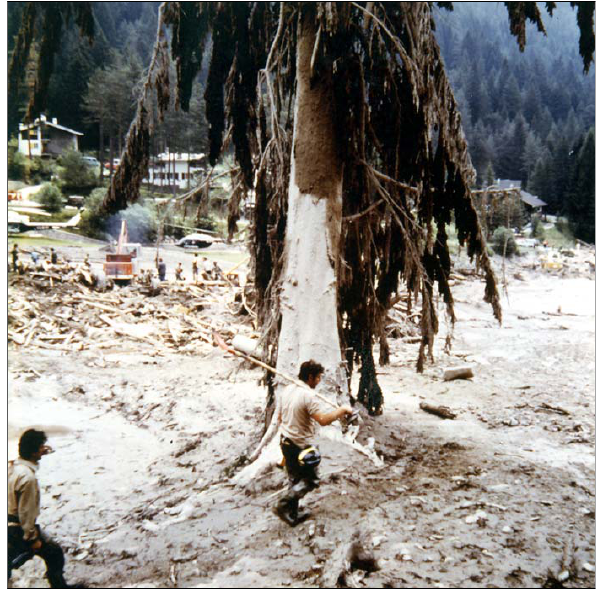
Fig. 15 ‐ Stava creek at the confluence with the sides of the valley and the valley bottom.